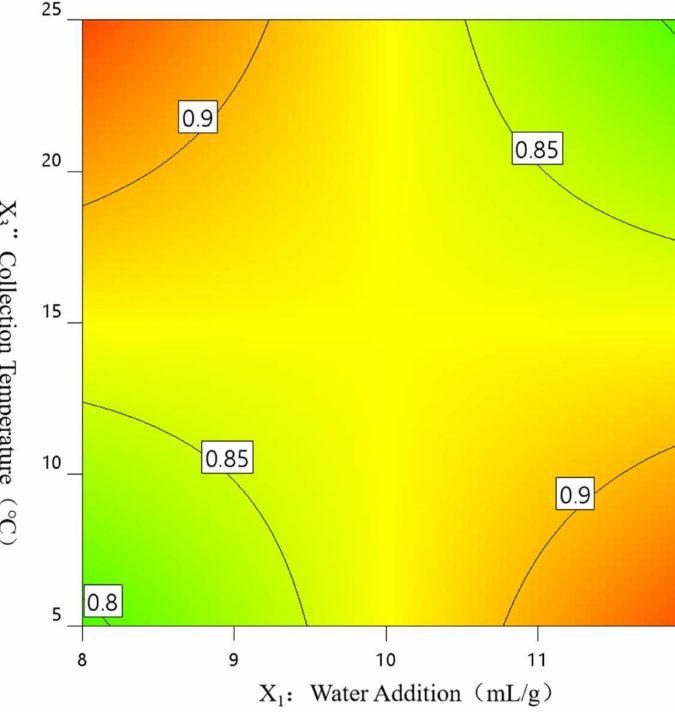
Figure 4. Volatile oil yield when the fixed distillation time was 4.5